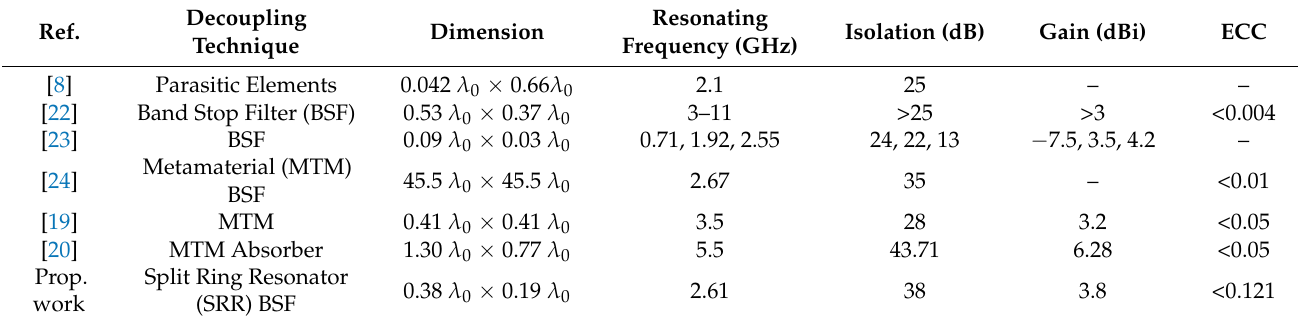
Table 1. Comparison with other decoupling network-based two-port MIMO antennas.